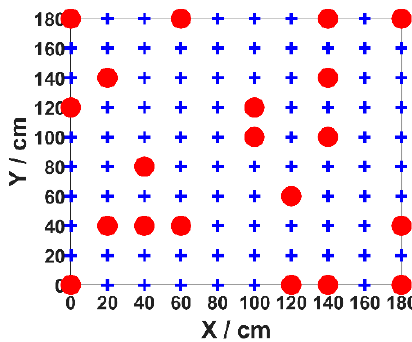
Figure 11. Arbitrary training data set. Sensors 2019 , 19 , x FOR PEER REVIEW